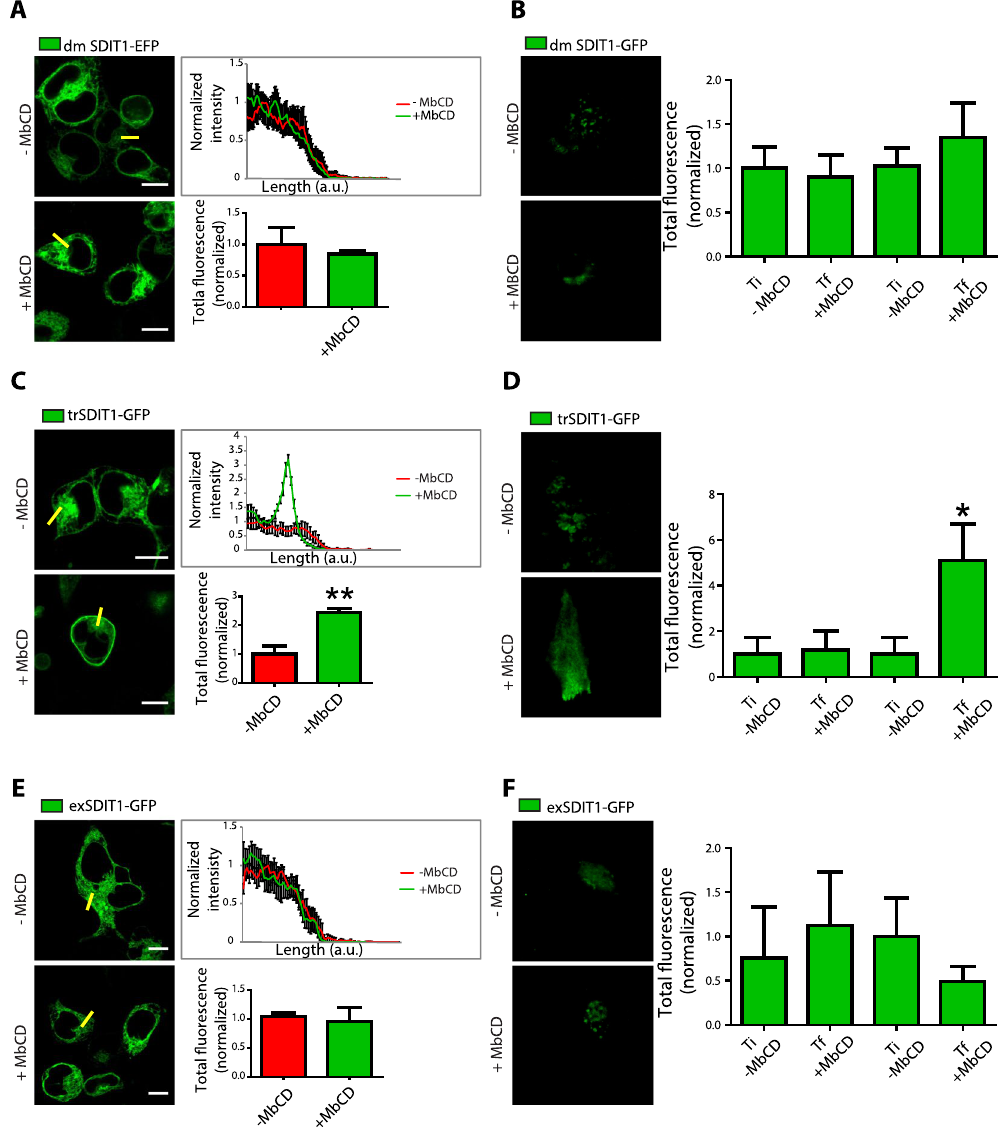
Figure 4. The extracellular CRAC domain from SIDT1 is part of a vesiculation signal required for translocation to the plasma membrane. ( A ) Representative confocal images of HEK293 cells expressing the SIDT1 double mutant from the CRAC domains (dmSIDT1). The right panel shows the line analysis illustrating the lack of translocation of the dmSIDT1 upon M β CD treatment. The lower panel shows the mean ± standard deviation of the fluorescence intensity in the line before and after M β CD treatment obtained from at least 40 independent experiments. ( B ) Total internal reflection fluorescence microscopy (TIRFM) representative images obtained with HEK293 cells expressing the dmSIDT1. The right panel shows the mean ± standard deviation from the total fluorescence of at least 30 independent measurements. ( C ) Representative confocal images of HEK293 cells expressing the SIDT1 transmembrane mutant (tmSIDT1). Notice the normal translocation to the plasma membrane after M β CD treatment. ( D ) Total internal reflection fluorescence microscopy (TIRFM) representative images obtained with the trSIDT1 mutant. ( E ) Representative confocal images of HEK293 cells expressing the exSIDT1 mutant. Notice that this mutant does not translocate to the plasma membrane after M β CD treatment. ( F ) Total internal reflection fluorescence microscopy (TIRFM) representative images obtained with the exSIDT1 mutant. Ti, the initial time of recording and Tf, final recording time. Total fluorescence normalized to Ti. In all panels scale bar: 10